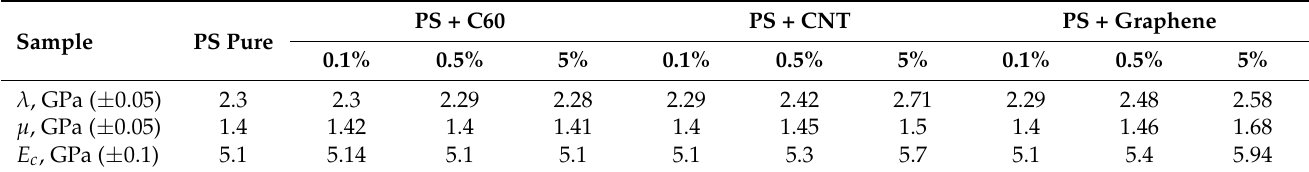
Table 2. Linear elastic moduli of PS-based nanocomposites obtained from ultrasonic measurements.